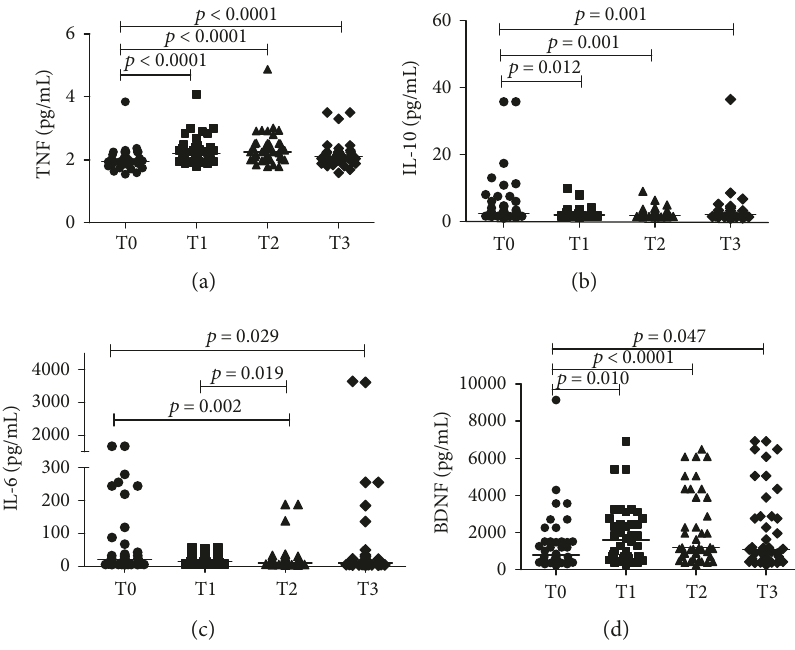
Figure 1: Plasma levels of TNF (a), IL-6 (b), IL-10 (c), and BDNF (d), in preterm infants ( N = 40 ) at four di ff erent time points (T0: umbilical cord blood, T1: 48 hours, T2: 72 hours, and T3: 3 weeks after birth). CBA was used in ex vivo analysis for cytokines and ELISA for BDNF. Mann – Whitney test was used for comparisons between medians of patients with normal motor development versus patients of lower than expected motor